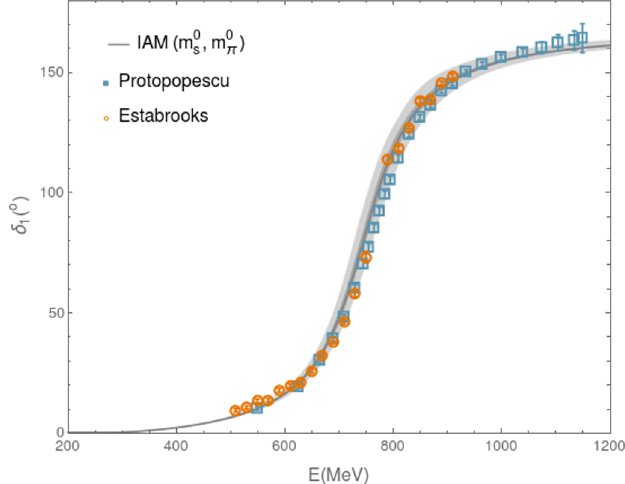
Figure 20 . Extrapolation to the physical point of the Fit IV solution in comparison with the experimental data.